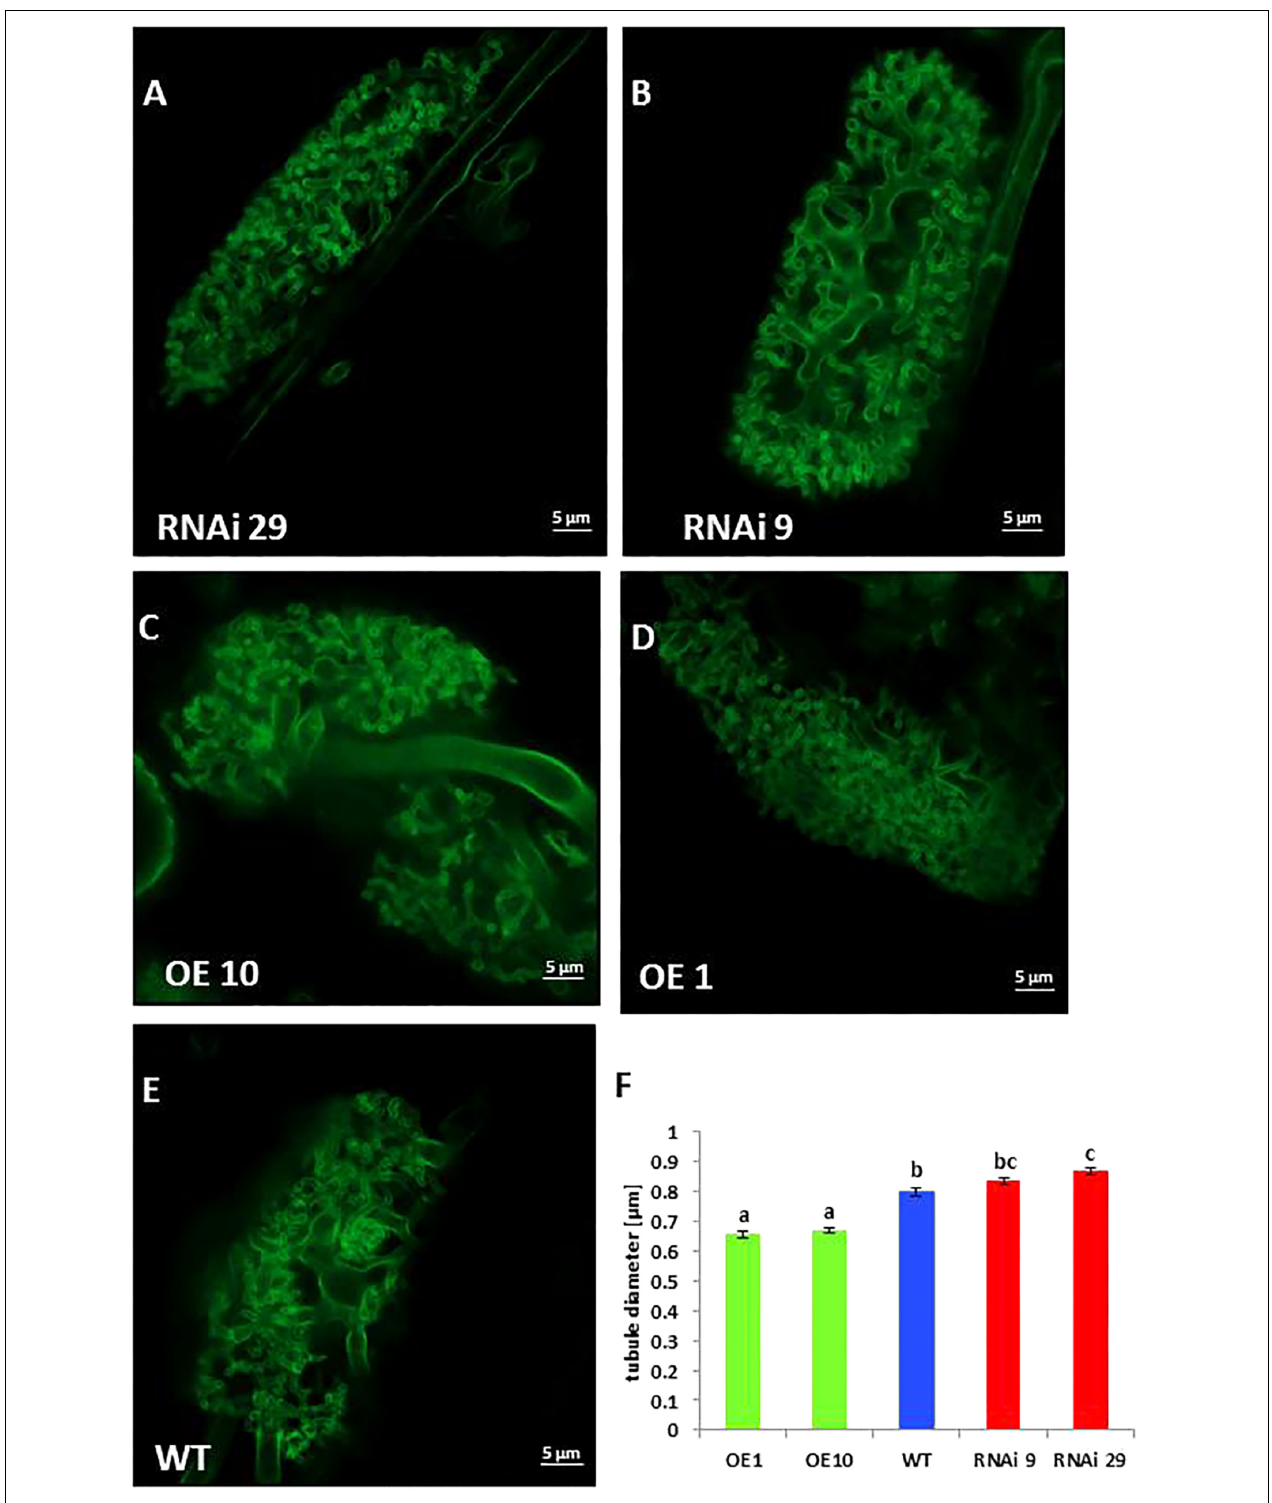
FIGURE 5 | Arbuscule morphology of NtMSBP1 -RNAi (A,B) , MSBP1 -overexpressing (C,D) or wild type (E) tobacco lines . Roots were stained with WGA-FITC and analyzed by confocal microscopy. Measurement of tubule diameters was performed using the ZEN2.0 confocal software (F) . Mean values and standard deviations of at least 20 different tubules from 10 different arbuscules for each genotype are shown and the SEM is given. Significant differences according to a one-way ANOVA are indicated by different letters with P < 0.001. Scale bars are 5 µ m in length.